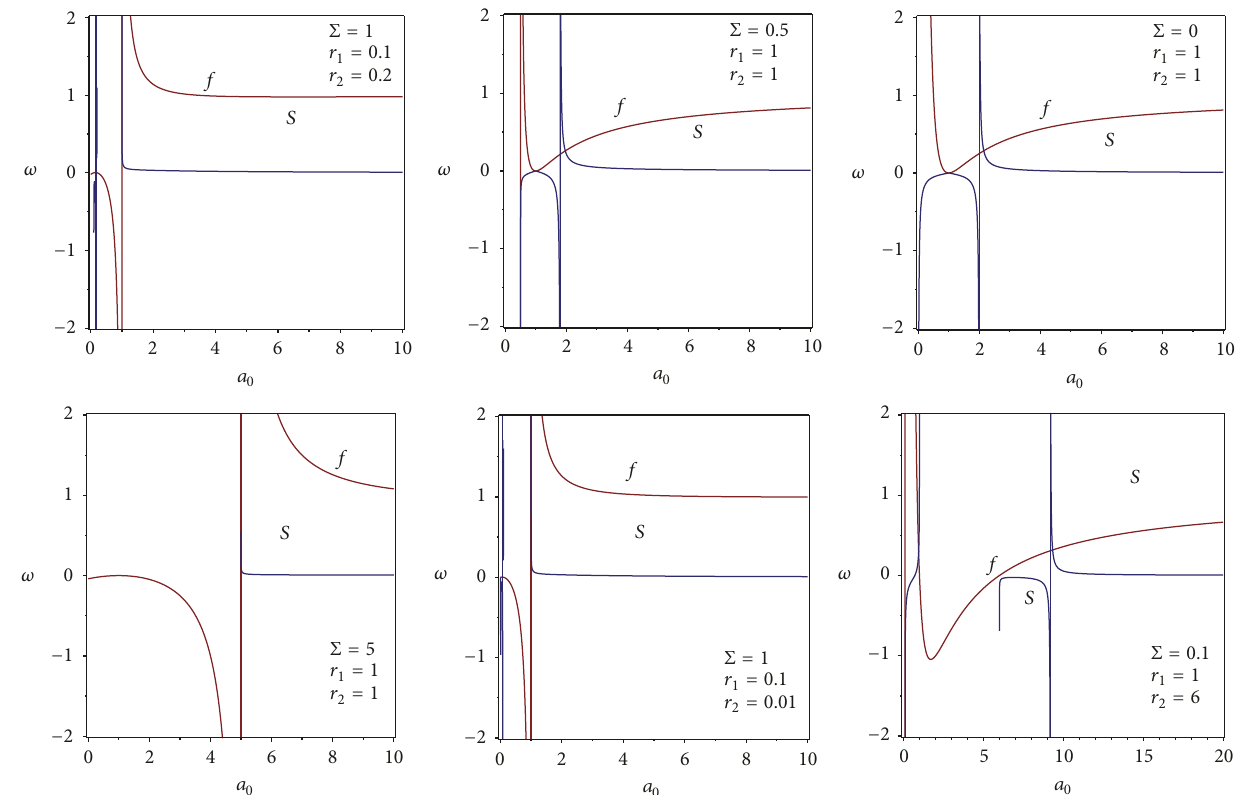
Figure 3: Stability regions of DTSW in terms of 𝜔 and radius of the throat 𝑎 0 for different values of Σ , 𝑟 1 , and 𝑟 2